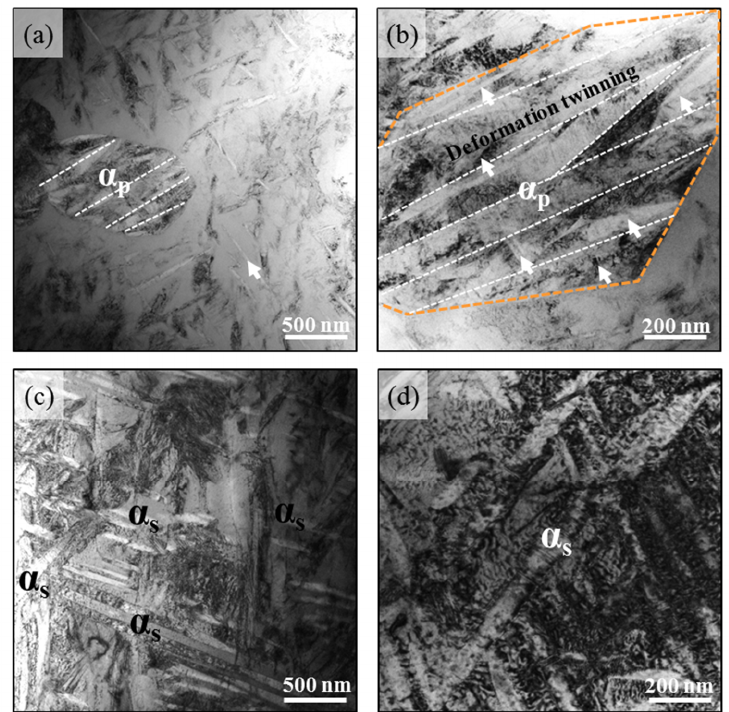
Figure 8. Deformation micromechanisms in two kinds of α - β metastable β -Ti alloys at dynamic loading. ( a ) Bright field TEM image of deformed α p,s + β Ti-45551 and its details ( b ); ( c ) bright field TEM image of deformed α s + β Ti-45551 and its details ( d ). The white arrows represent deformation twinning.